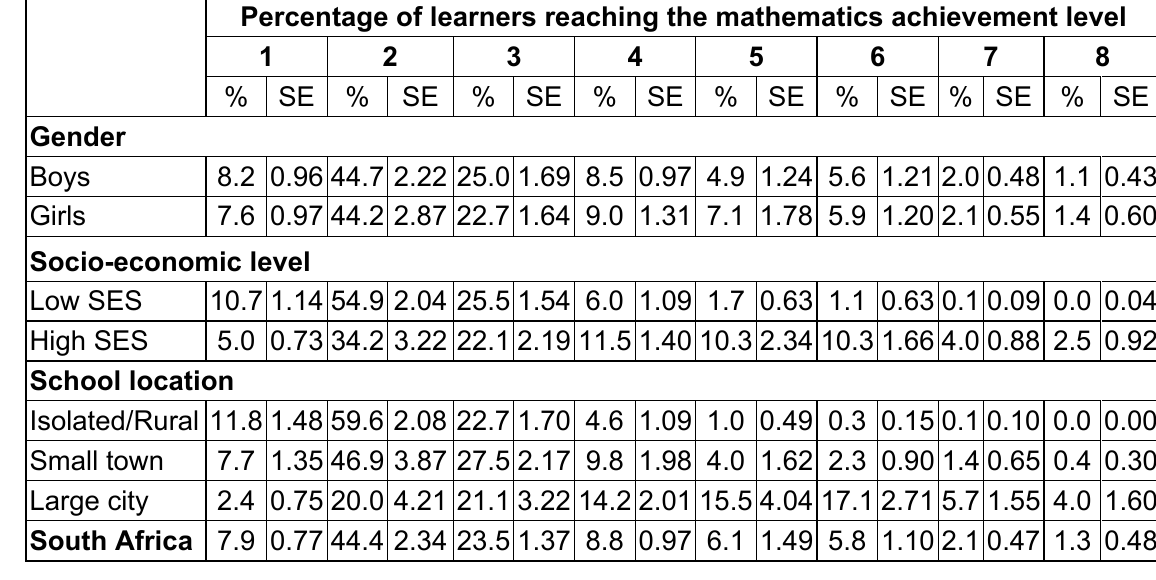
Table 3. Mastery levels for sub-groups (SACMEQ II Research Report,